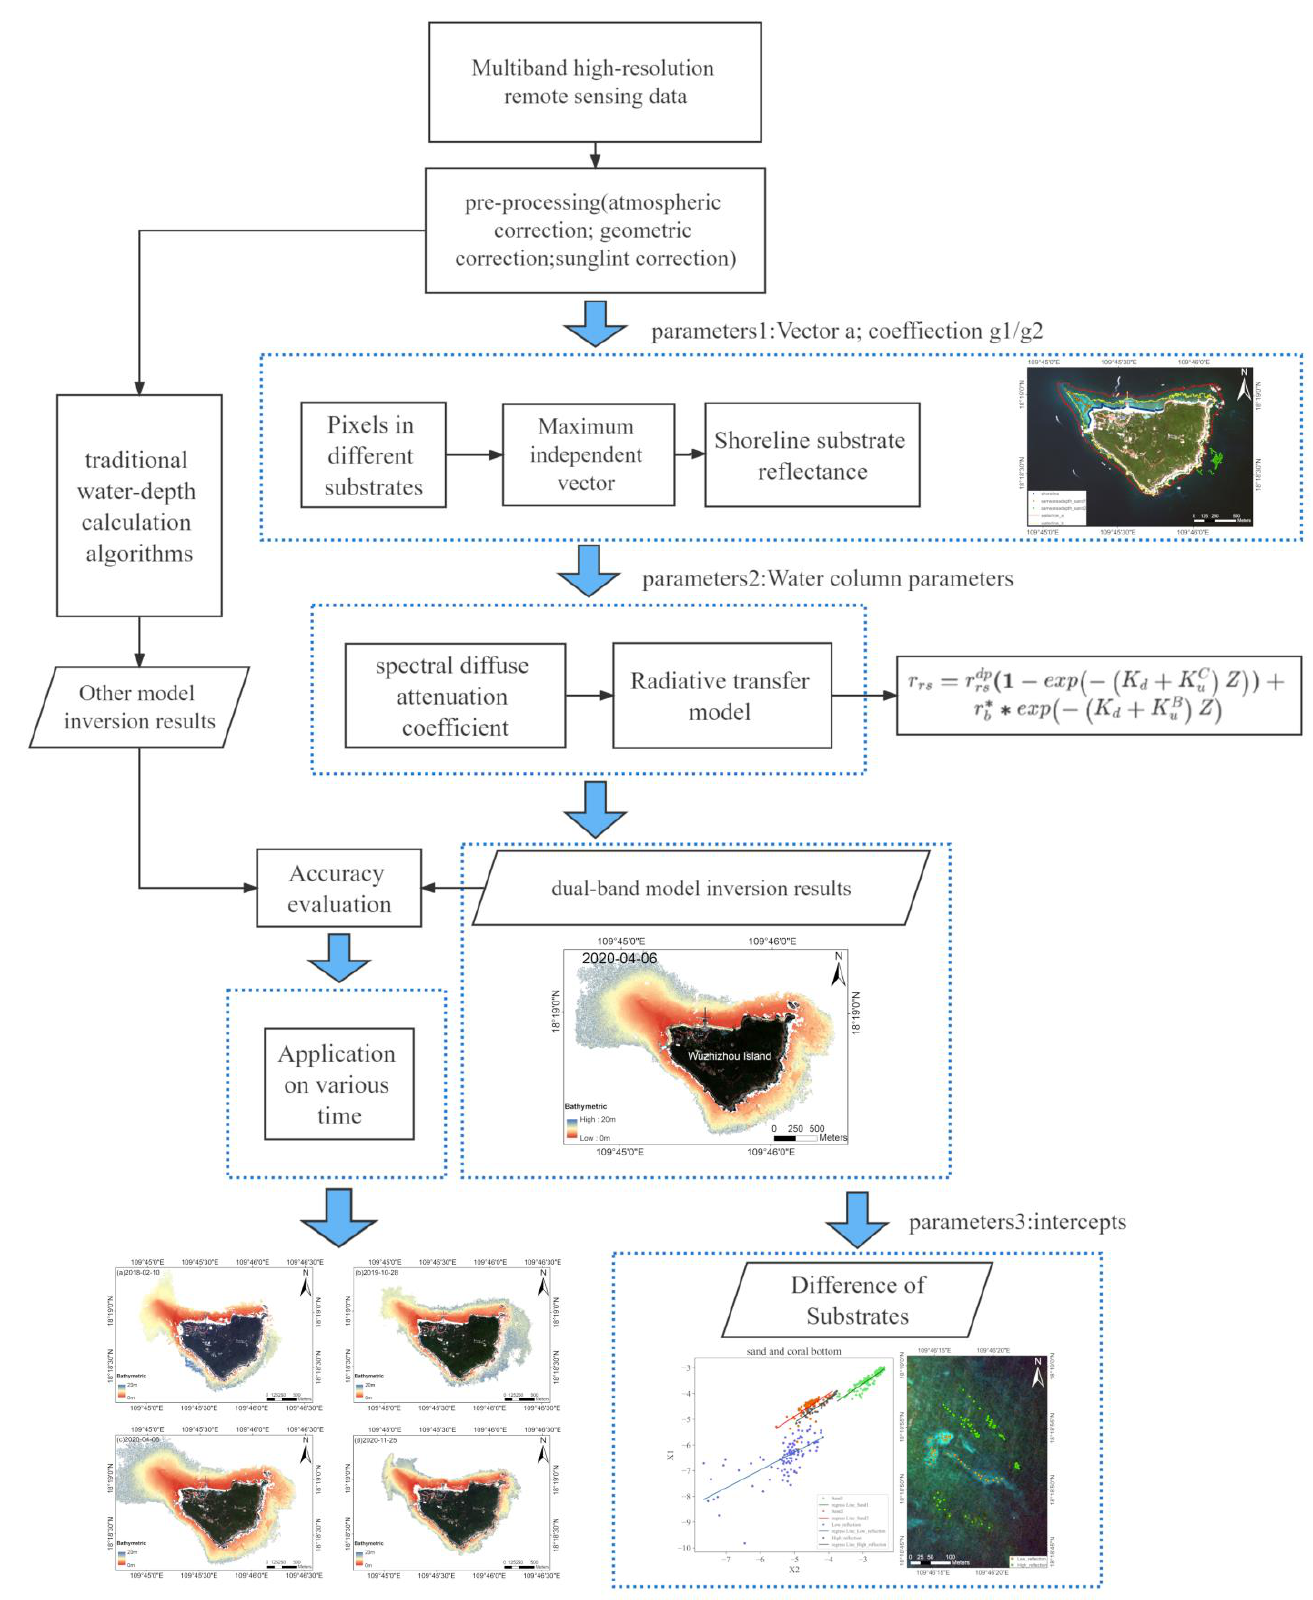
Figure 3. The workflow of water depth inversion. Based on the semi-analytical water radiative transfer model proposed by Lee [24 – 26], we used the quasi-analytical algorithm (QAA) and attenuation coefficient algorithm to